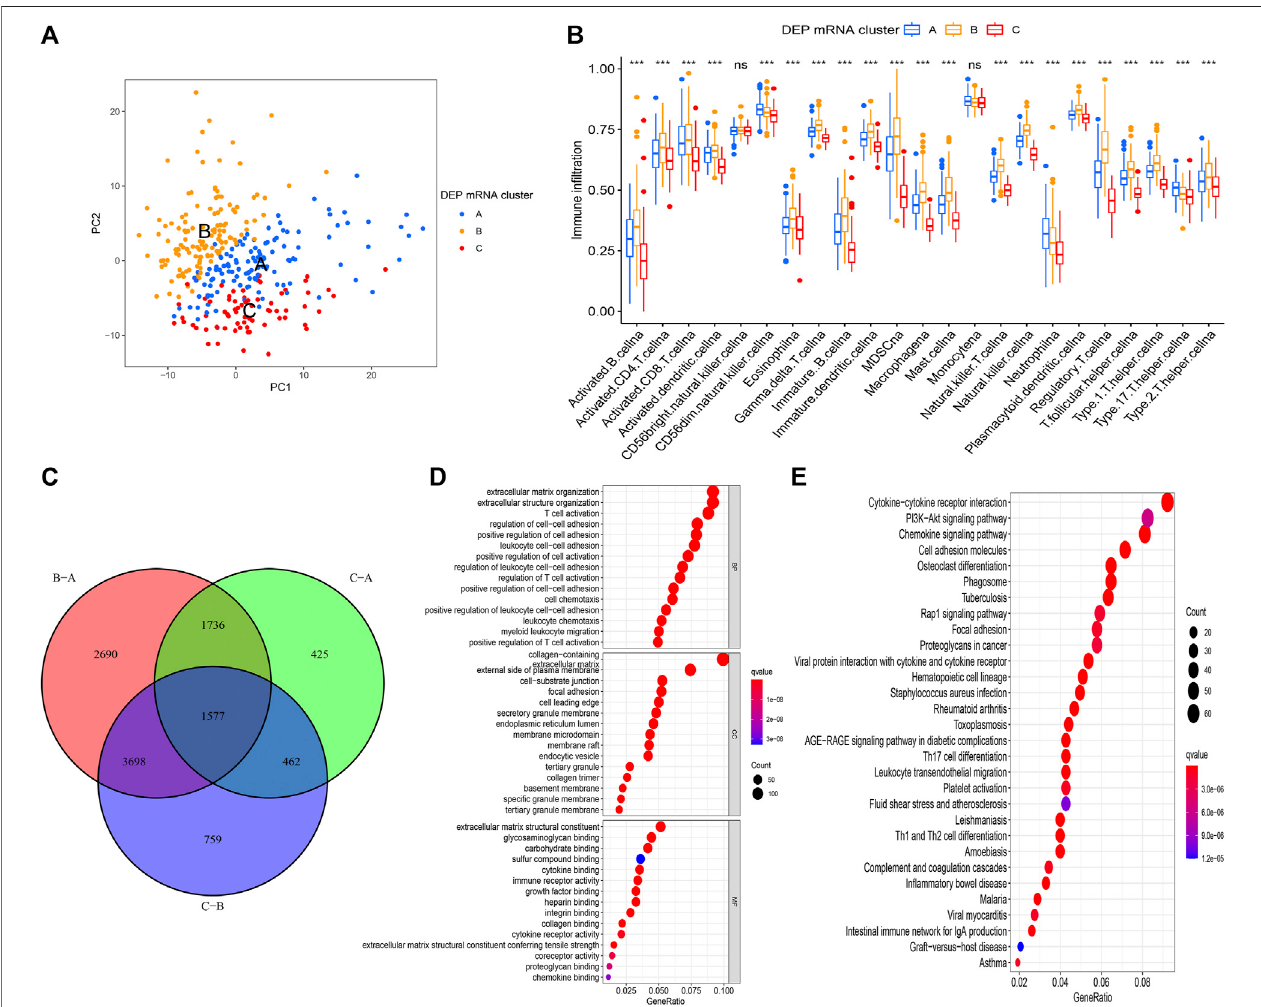
FIGURE3| (A) PCA for thetranscriptome pro fi lesofthreeDEP mRNA clusters showing signi fi cantdifferencesintranscriptomebetweendifferentclusters. (B) The abundance of each TME in fi ltrating cell in the three DEP mRNA clusters. The upper and lower ends of the boxes represent interquartile range of values. The lines in the boxes represent the median value, and the colored dots represent outliers. The asterisks represent the statistical p -value (* p < 0.05; ** p < 0.01; *** p < 0.001). (C) The venn diagram showing the overlapping genes between the three clusters. (D) GO enrichment analysis of the overlapping gene signatures. (E) KEGG enrichment analysis of the overlapping gene